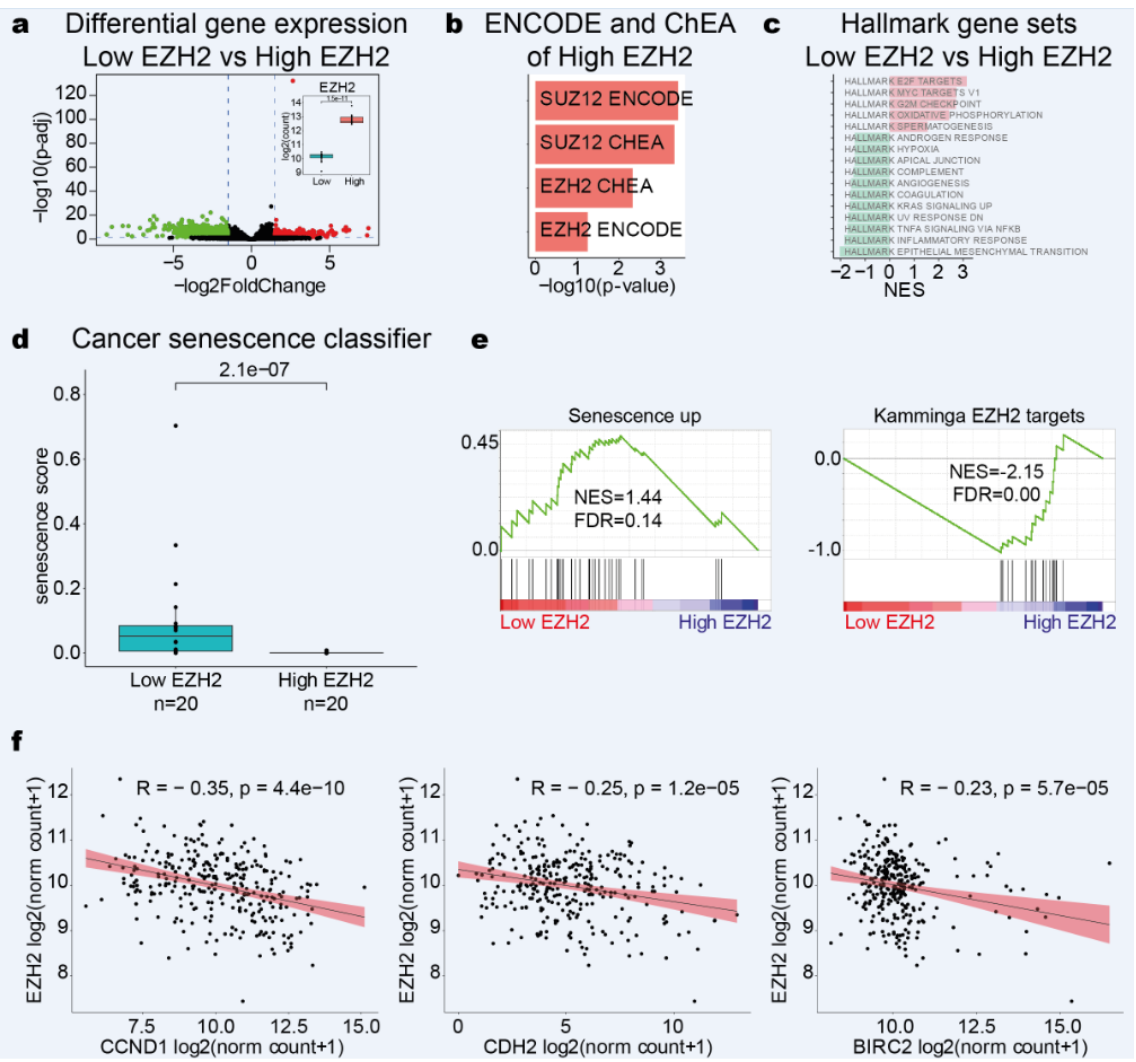
Figure 6: High EZH2 expression reduces senescence in cervical cancer. a) Volcano plot shows the differentially expressed genes between CC patients with low EZH2 and high EZH2. An adjusted p-value <0.05 and an FC of 1.5 were considered statistically significant. b) TFs associated with genes regulated by high EZH2. A p-value <0.05 was considered statistically significant. c) The top hallmark GSEA pro- cesses enriched in low EZH2 (green) and high EZH2 (red). NOM p-value <0.05 were considered statis- tically significant. d) Senescence score between CC patients with low EZH2 and high EZH2. Wilcoxon test, p-value <2.1e-07. e) GSEA plots of the differentially expressed genes between CC patients with low EZH2 and high EZH2. The processes correspond to genes enriched in cellular senescence. f) Cor- relation plots between EZH2 with CCND1, CDH2, and BIRC2 in TCGA. A p-value <0.05 was considered statistically